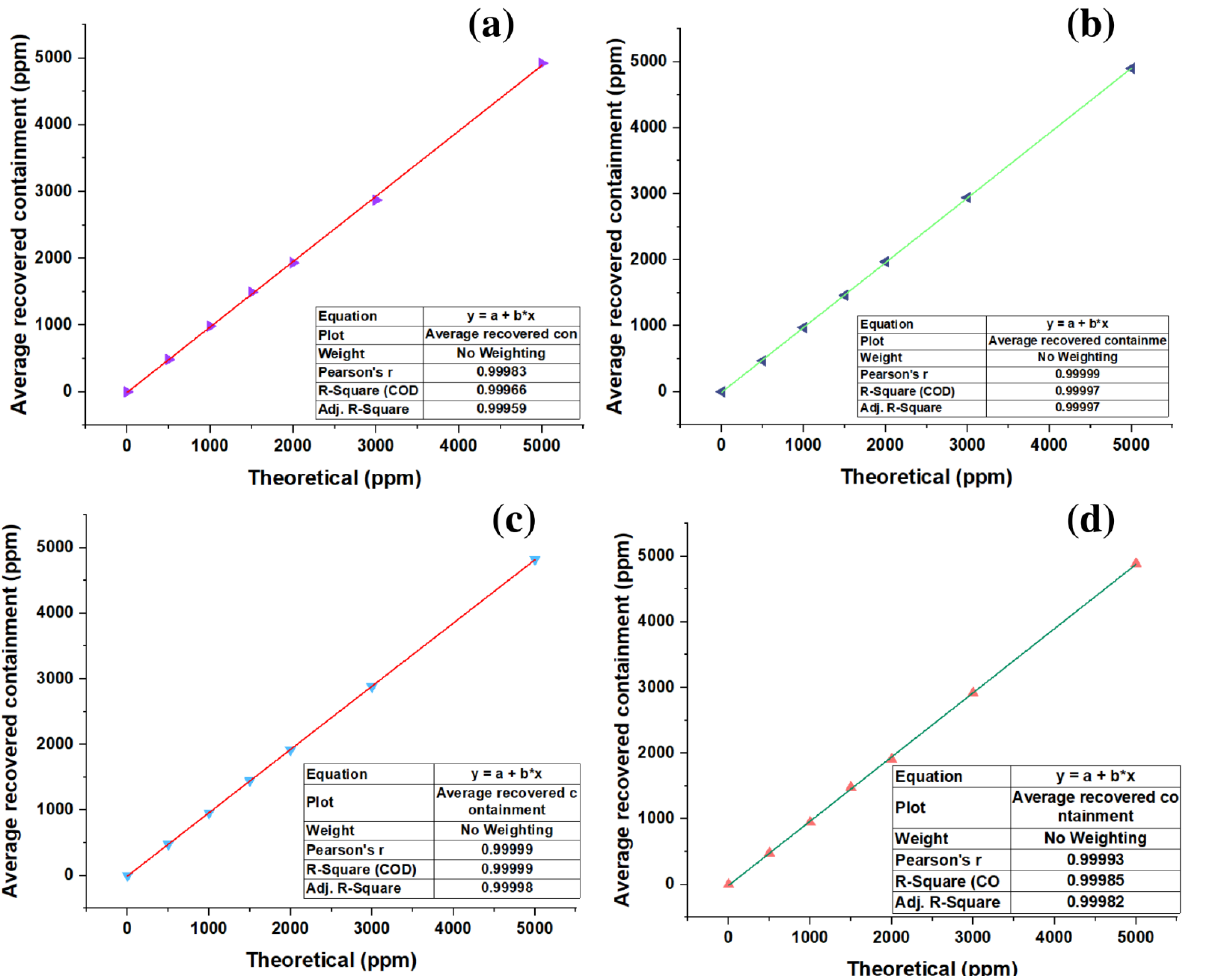
Molecules 2023 , 28 , x FOR PEER REVIEW Figure 7. Linearity: ( a ) repeatability in calibration curve; ( b ) reproducibility in calibration curve; ( c ) repeatability for SPE; ( d ) reproducibility for SPE.